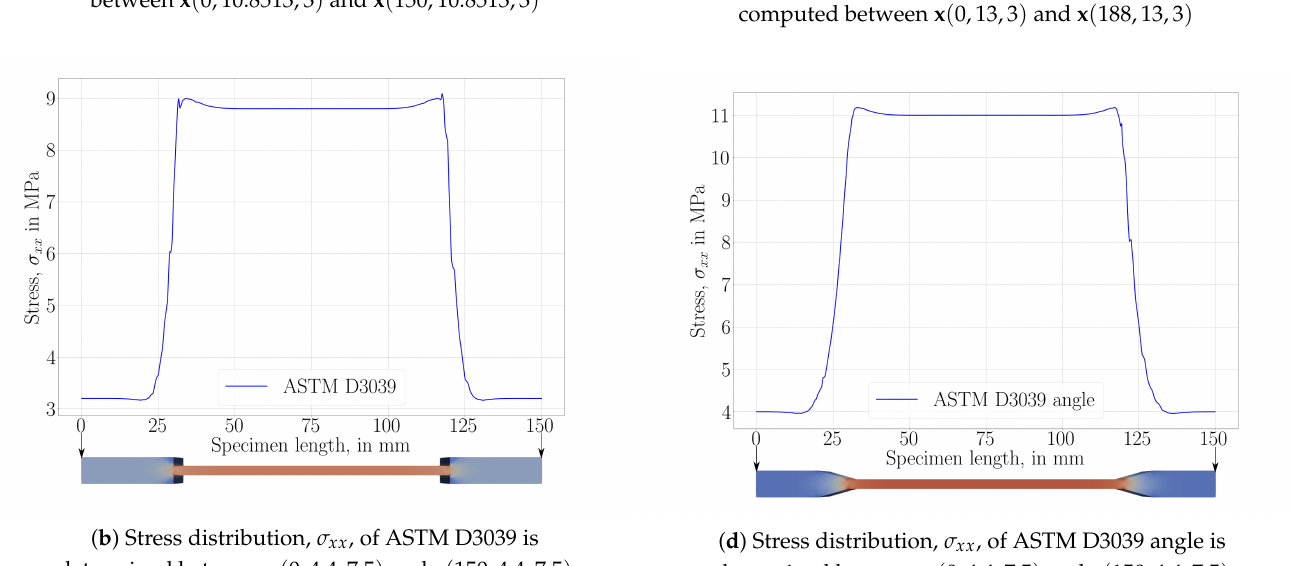
Figure 12. Stress results, σ xx , of uniaxial tensile test simulations of different specimen geometries: ( a ) ISO527-2, ( b ) ASTM D3039, ( c ) ISO-modified and ( d ) ASTM D3039